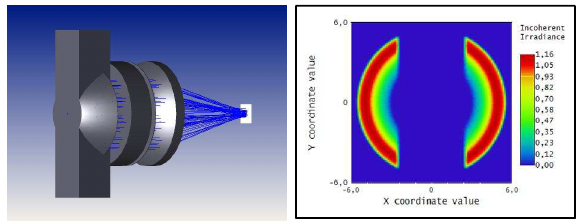
Fig. 2. The measurement platform showing the (vertical) light guide and the readout optics with the parabolic lens (left) and the relative irradiance distribution of the reflected rays at the spatial filter to be focused to the detector